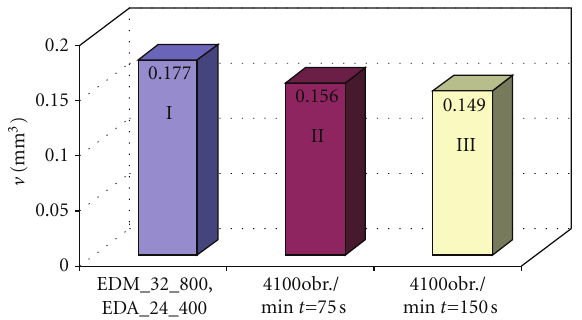
Figure 16: Comparative results. Investigation of abrasive wear resistance measured with Skoda-Savin method: (I) samples of steel 45 machined by grinding, (II) EDM— U = 180 V, I = 32 A, Ti = 800 μ s and EDA: U = 200V, I = 24A, Ti = 400 μ s; (III, IV) EDM, EDA and with roto peen: n = 4100 rev/min for the time of: t = 75s (III); t = 150s (IV). (Lubrication conditions—kerosene and machine oil solution −